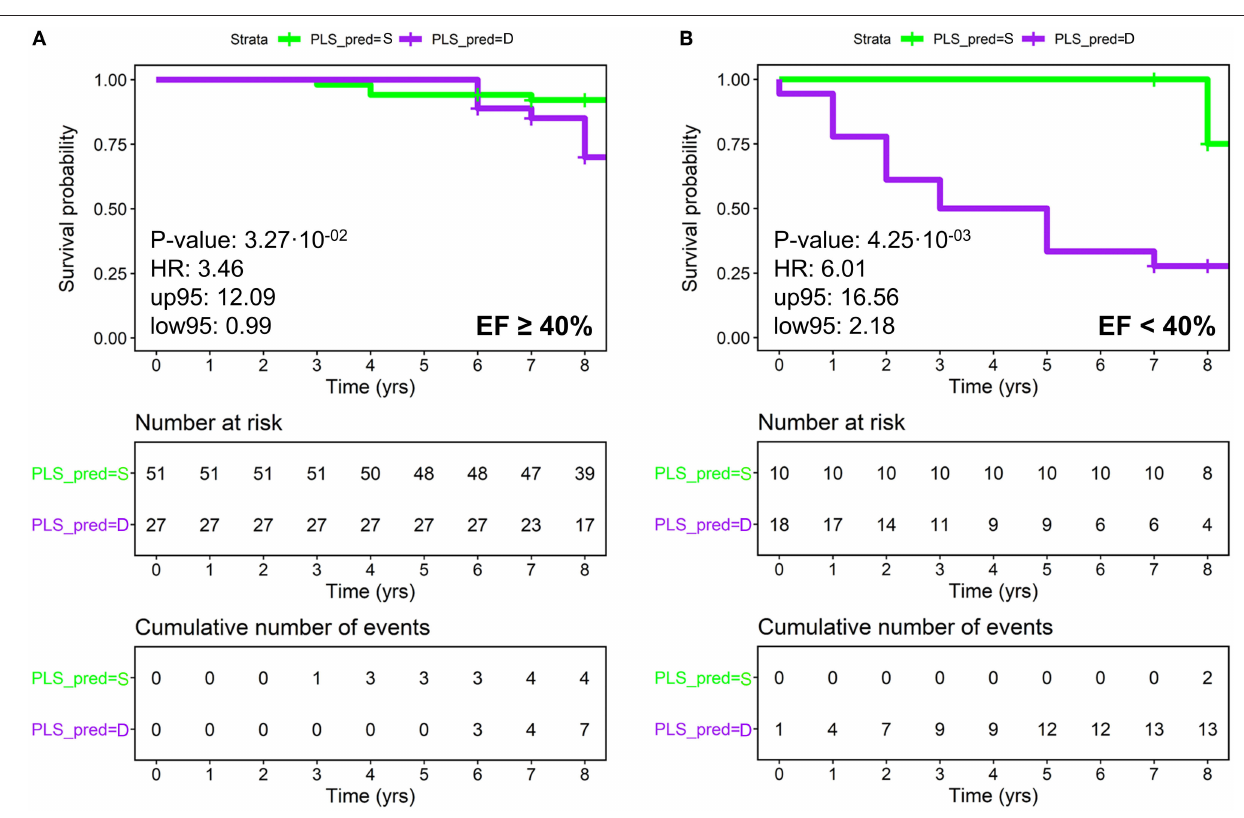
FIGURE 4 | Patients with HF divided according to LVEF subclasses (A) LVEF ≥ 40% (low risk), (B) LVEF < 40% (high-risk), plotting actual survival over time (measured in years) according to estimated risk based on metabolomics (KM curves). Low-risk patients are colored in green and high-risk in purple. The P -values are calculated using the Log-Rank test. Censored events represent either the time of last recorded clinical follow-up, or time of death. Number at risk: number of patients stratified according to metabolomics. Cumulative number of events: total number of deceased patients at each time point for each metabolomic group. (A) KM analysis on metabolomic classification of patients with LVEF ≥ 40%; (B) KM analysis on metabolomic classification of patients with LVEF < 40%. PLS_PRED = S, predicted by PLS as survivor; PLS_PRED = D, predicted by PLS as